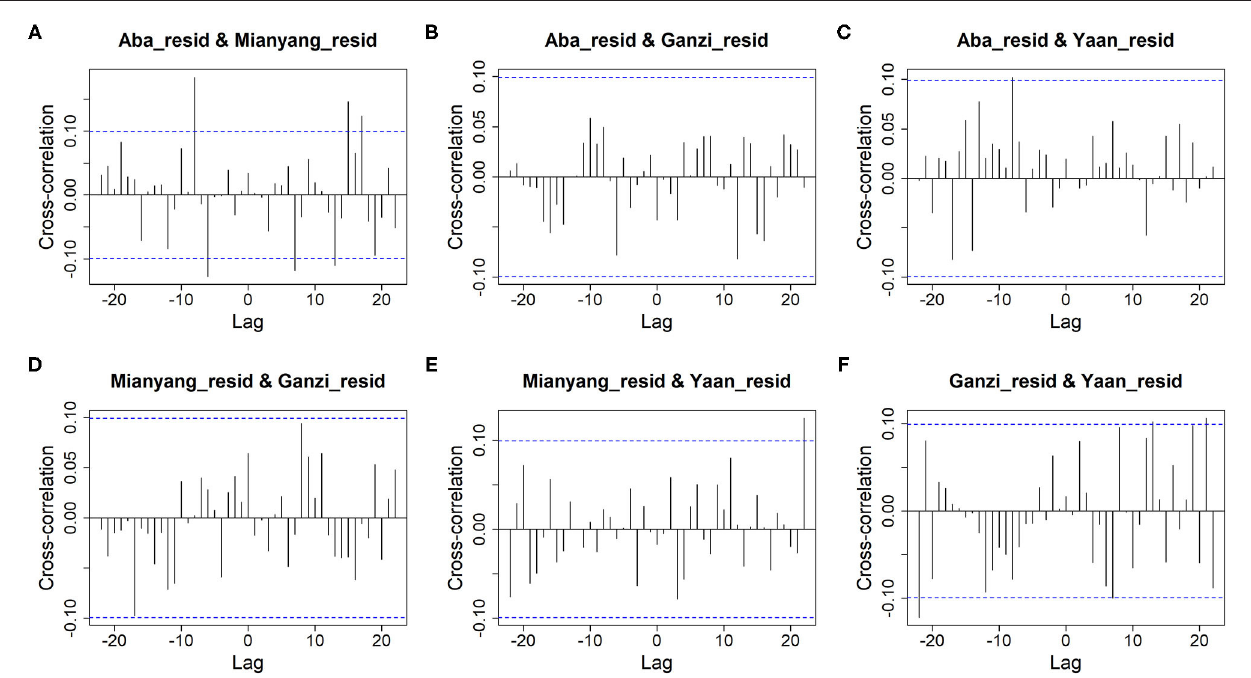
FIGURE 4 | The cross-correlation of the residuals between cities of cluster 1. (A) The residuals of Aba and Mianyang. (B) The residuals of Aba and Ganzi. (C) The residuals of Aba and Ya’an. (D) The residuals of Mianyang and Ganzi. (E) The residuals of Mianyang and Ya’an. (F) The residuals of Ganzi and Ya’an.